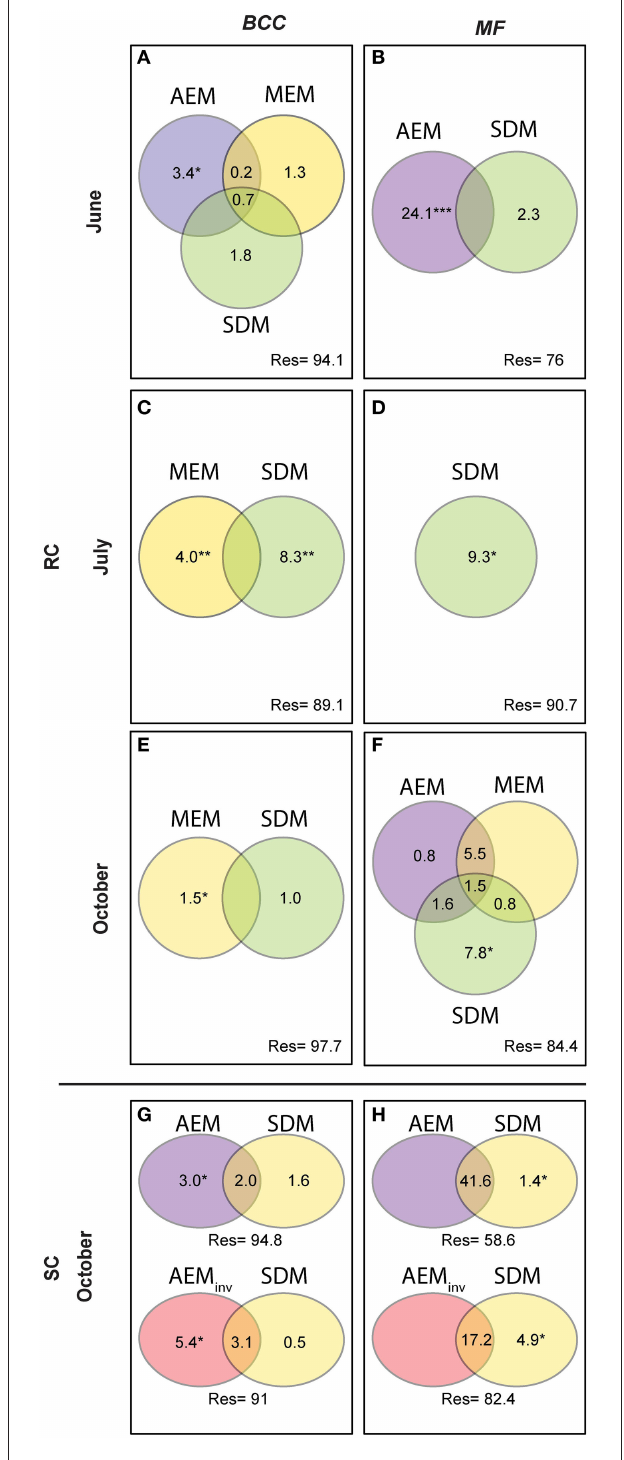
FIGURE 5 | Variation partitioning analysis performed for BCC and MF on significant spatial (AEM and MEM) and solute dependent models (SDM). AEM and its shared fractions with MEM models catch spatially-directed processes such as passive downstream transport of